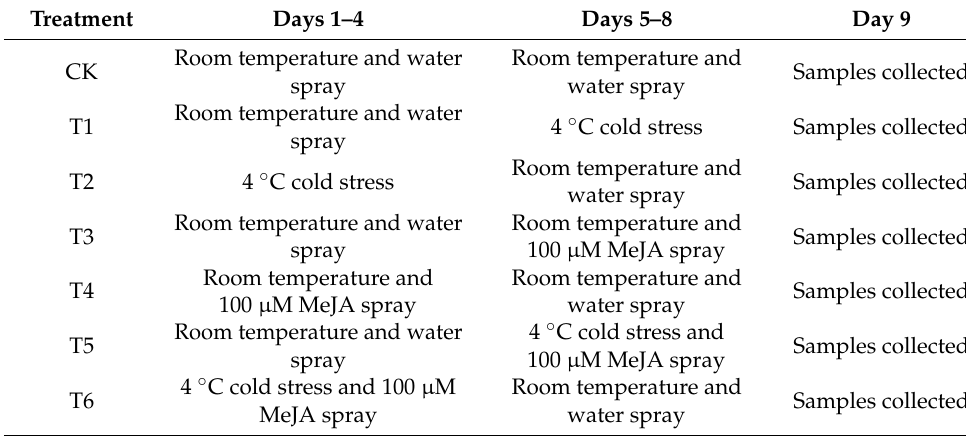
Table 1. Descriptions of control and six experimental treatments applied to tea